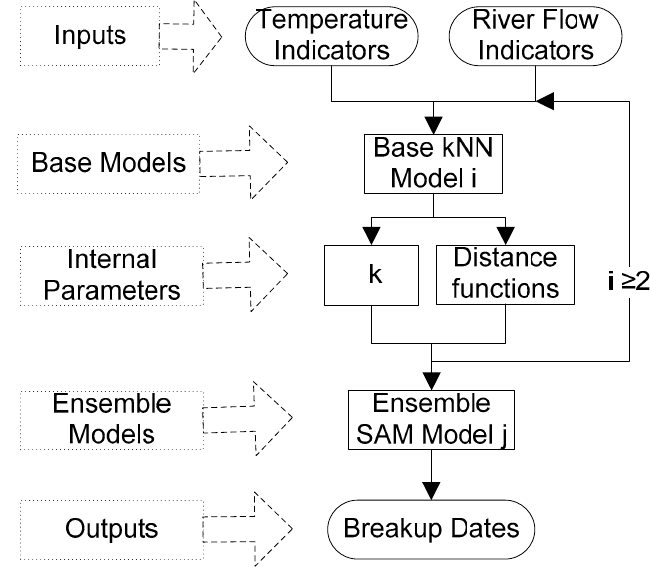
Figure 2. Framework of k-nearest neighbor (kNN)-based stacking ensemble learning (KSEL).